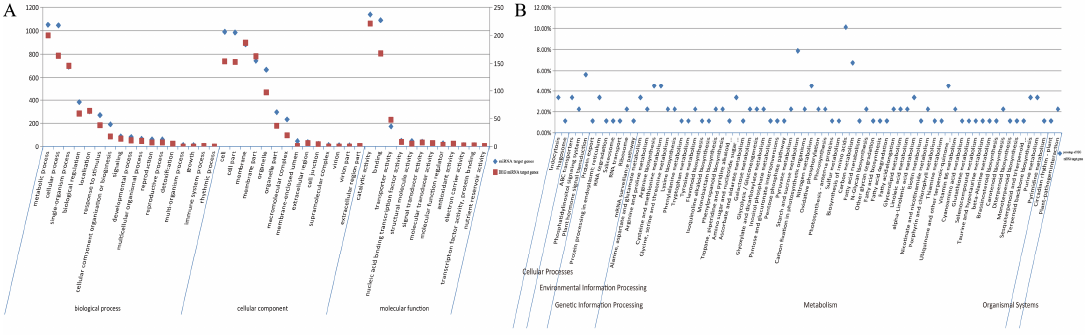
Figure 5. ( A ) GO subclassification of miRNA target genes. ( B ) KEGG subclassification of miRNA Figure 5. (A) GO subclassification of miRNA target genes. (B) KEGG subclassification of miRNA target target genes.